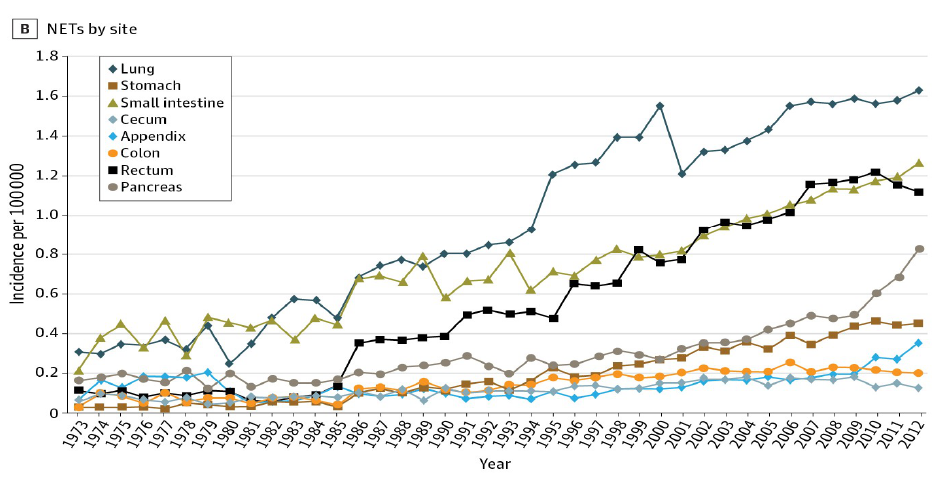
Figure 2. Incidence trends of neuroendocrine tumors (NETs) from 1973 to 2012 [4].